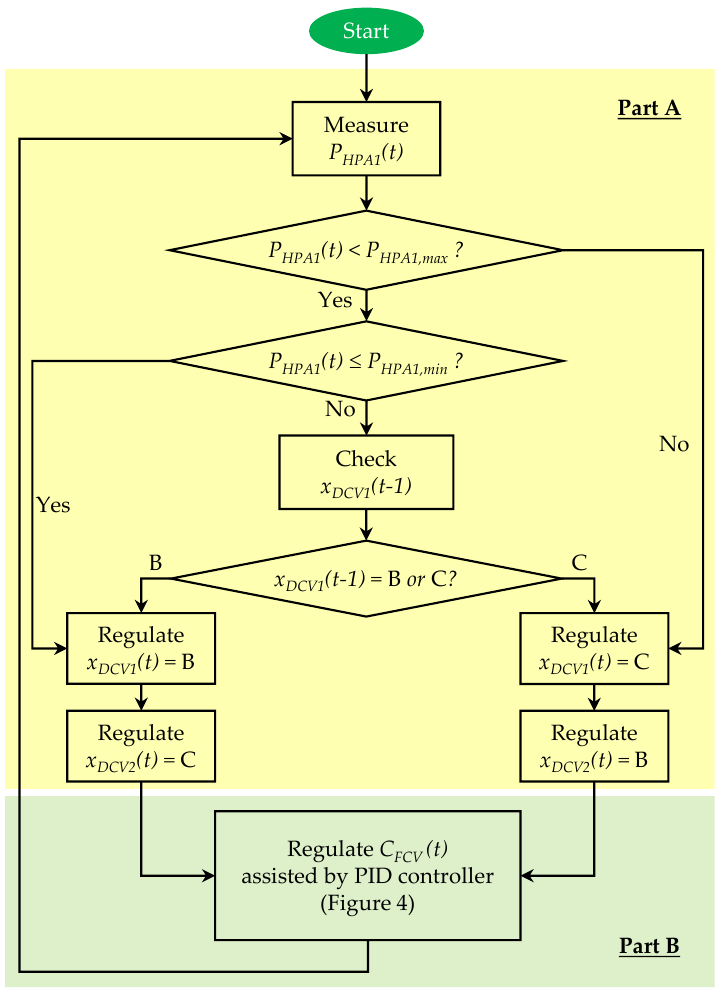
Figure 3. A proposed control strategy of FEC module.